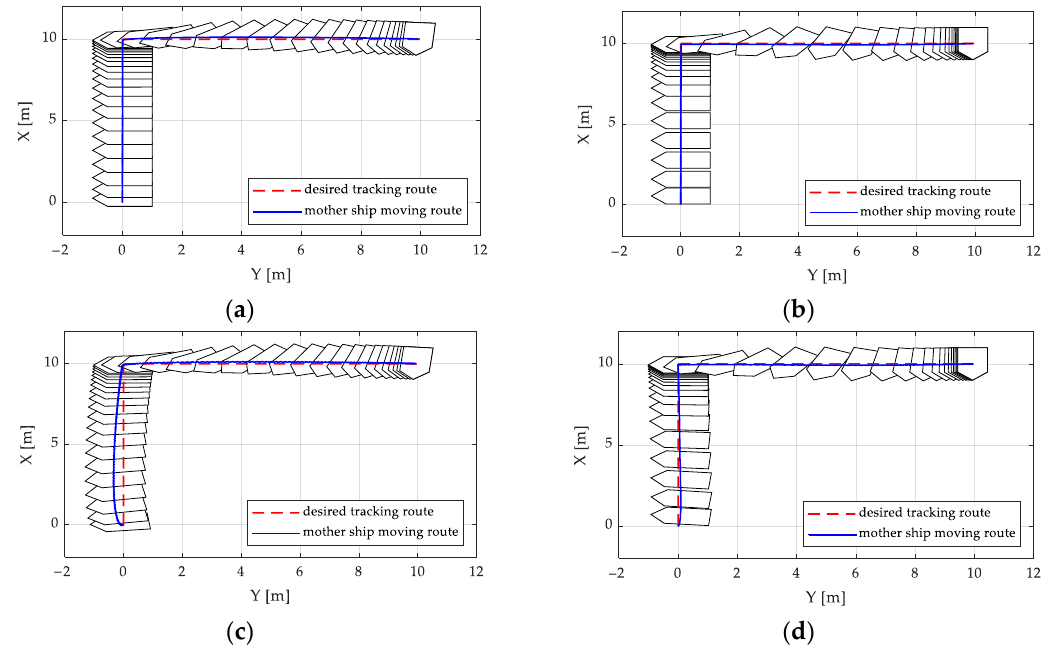
Figure 6. The set point tracking performance of the barge ship when conveyed by the tugboats. ( a ) Conveyed with the H ∞ controller; ( b ) conveyed with our sliding mode controller; ( c ) conveyed with the H ∞ controller under disturbance; ( d ) conveyed with our sliding mode controller under disturbance.